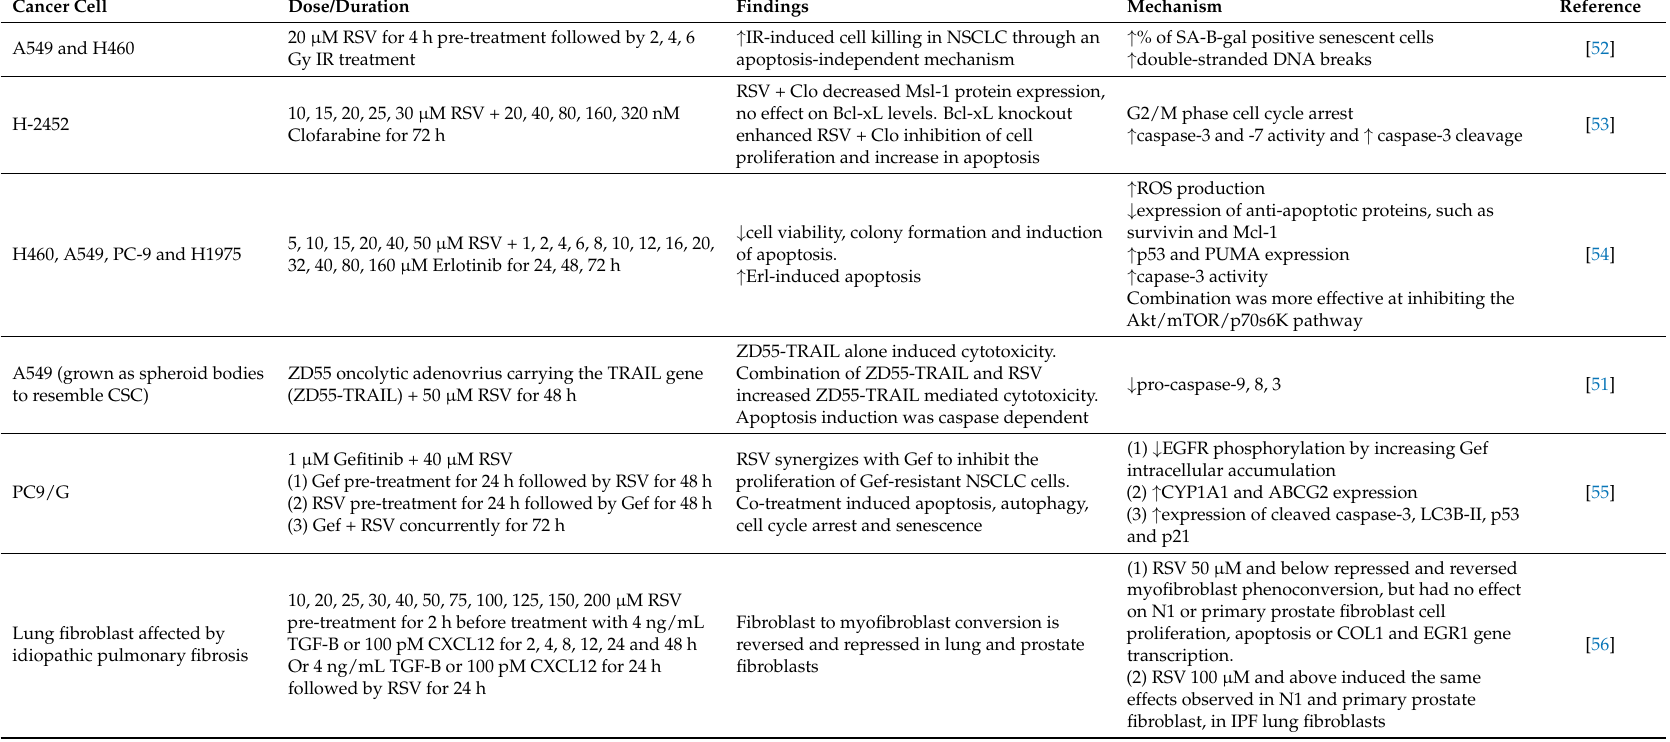
Table 2. Effects of resveratrol (RSV) in a combination treatment against lung cancer: in vitro